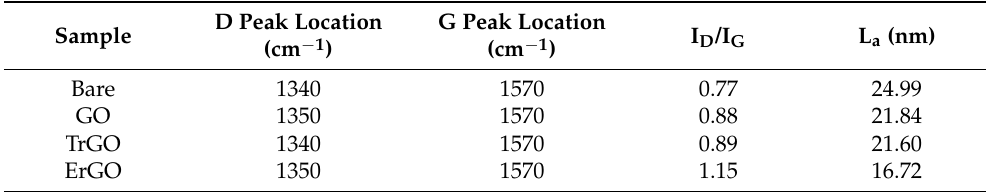
Table A2. The experimental values of the peak locations, I D /I G ratios, and the average crystallite sizes of the sp 2 lattice (L a ) of all samples.